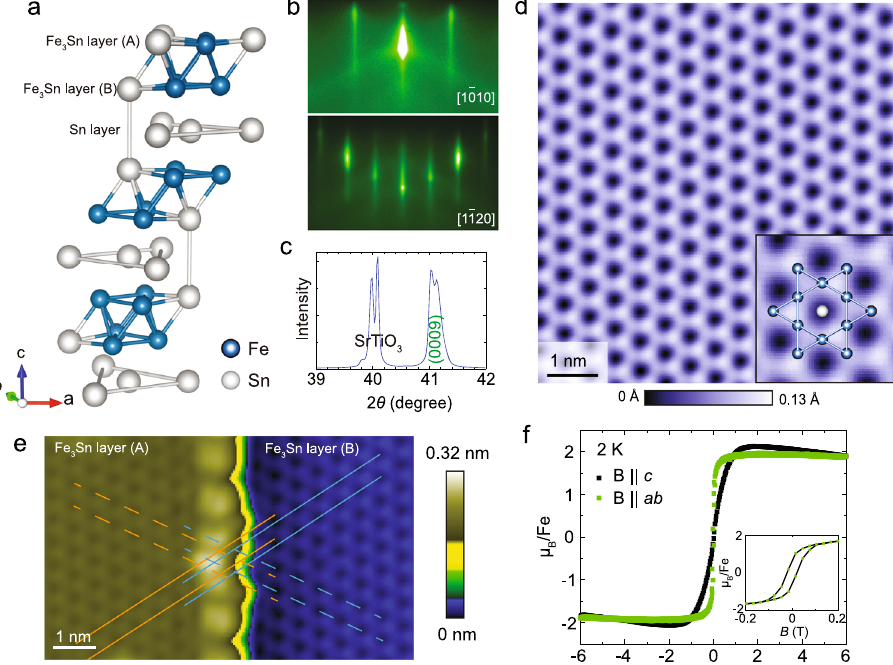
Fig. 1 Structural and magnetic characterization of Fe 3 Sn 2 fi lms. a Crystal structure of one unit cell of Fe 3 Sn 2 . Blue and white spheres represent Fe and Sn atoms, respectively. b Post-growth RHEED images of Fe 3 Sn 2 thin fi lm along two high-symmetry in-plane directions. c XRD data of the sample showing the SrTiO 3 substrate peak and the Fe 3 Sn 2 (0009) peak. d High-resolution STM topograph acquired at the Fe 3 Sn surface. Inset in d magni fi es a small region with the schematic of the kagome structure of Fe 3 Sn layer superimposed. e STM topograph containing an Fe 3 Sn – Fe 3 Sn atomic step. Orange (blue) lines follow the nearest-neighbor Sn atoms in the upper (lower) Fe 3 Sn layer (See Supplementary Note 2). Solid and dashed lines are parallel to the in-plane a and b lattice vectors, respectively. f Magnetization curves as a function of the magnetic fi eld applied in the ab -plane (green) and along the c -axis (black) after subtracting the magnetic moment from the substrate. Inset in f displays the hysteresis loop near 0 T at 2 K. STM setup conditions: d I set = 100 pA, V sample = 100 mV; e I set = 280 pA, = 35 V sample